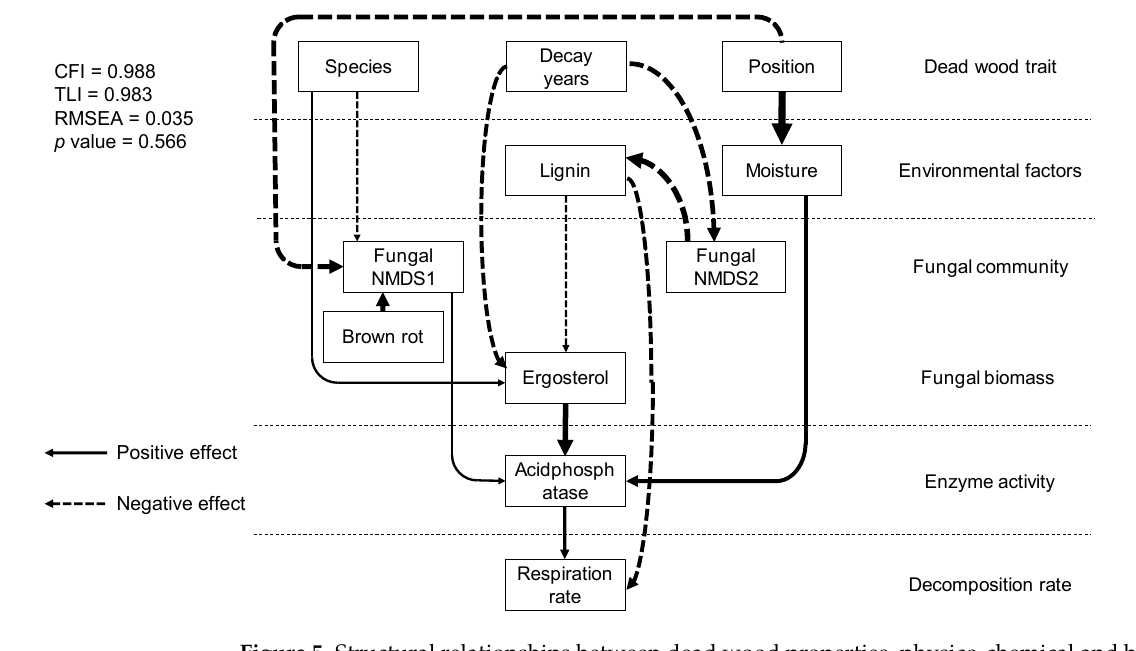
Figure 5. Structural relationships between dead wood properties, physico-chemical and biological factors, fungal community structure, enzyme activity, and in situ dead wood respiration rate. The lines and dotted arrows indicate positive and negative relationships between factors, respectively. The arrow width indicates standardized path coefficients. All of the paths shown are significant ( p < 0.05).